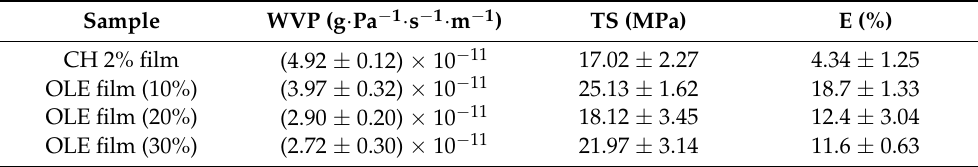
Table 2. Moisture permeability of films at 23 ◦ C and 50% relative humidity. Tensile strength and elongation at break. Results are expressed as average ± standard